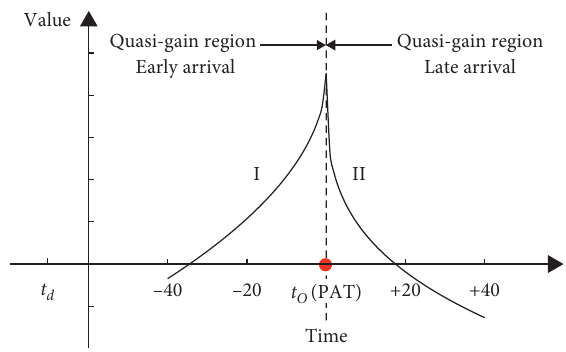
Figure 3: The optimal estimation result of Framework B.